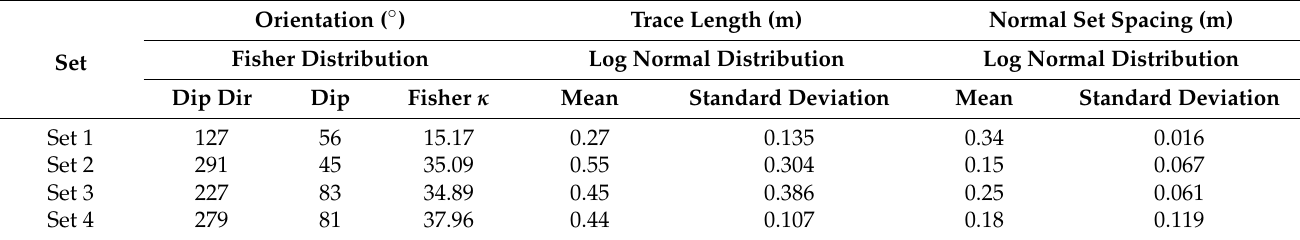
Figure 9. The orientation results for Site 1 in the stereographic projection (i.e., equal angle net on the lower hemisphere). Table 1. Summary of the statistical parameters of Site 1 identified from PCM.